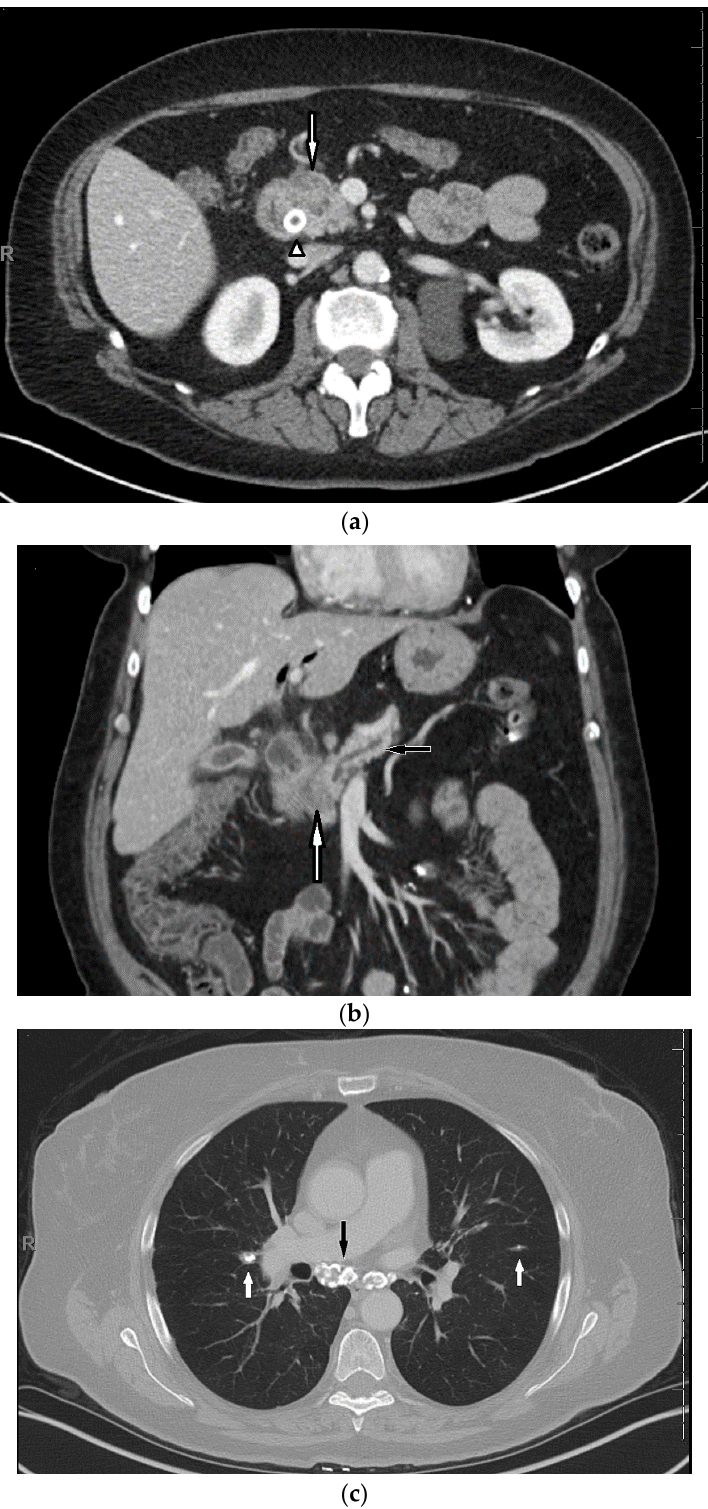
Figure 1. Axial ( a ) and coronal ( b ) intravenous contrast-enhanced CT scans of the chest, abdomen, and pelvis at initial presentation show a 3.1 × 2.1 cm hypo-enhancing mass in the head of the pancreas (white arrows) with mild upstream pancreatic ductal dilatation and parenchymal atrophy (black arrow). The dilated biliary tree has been decompressed via a metal common bile duct stent (white arrow head); ( c ) Images through the chest on lung windows show calcified mediastinal lymph nodes (black arrow) and calcified pulmonary nodules (white arrows)—non-specific sequela of prior granulomatous process, including sarcoid.